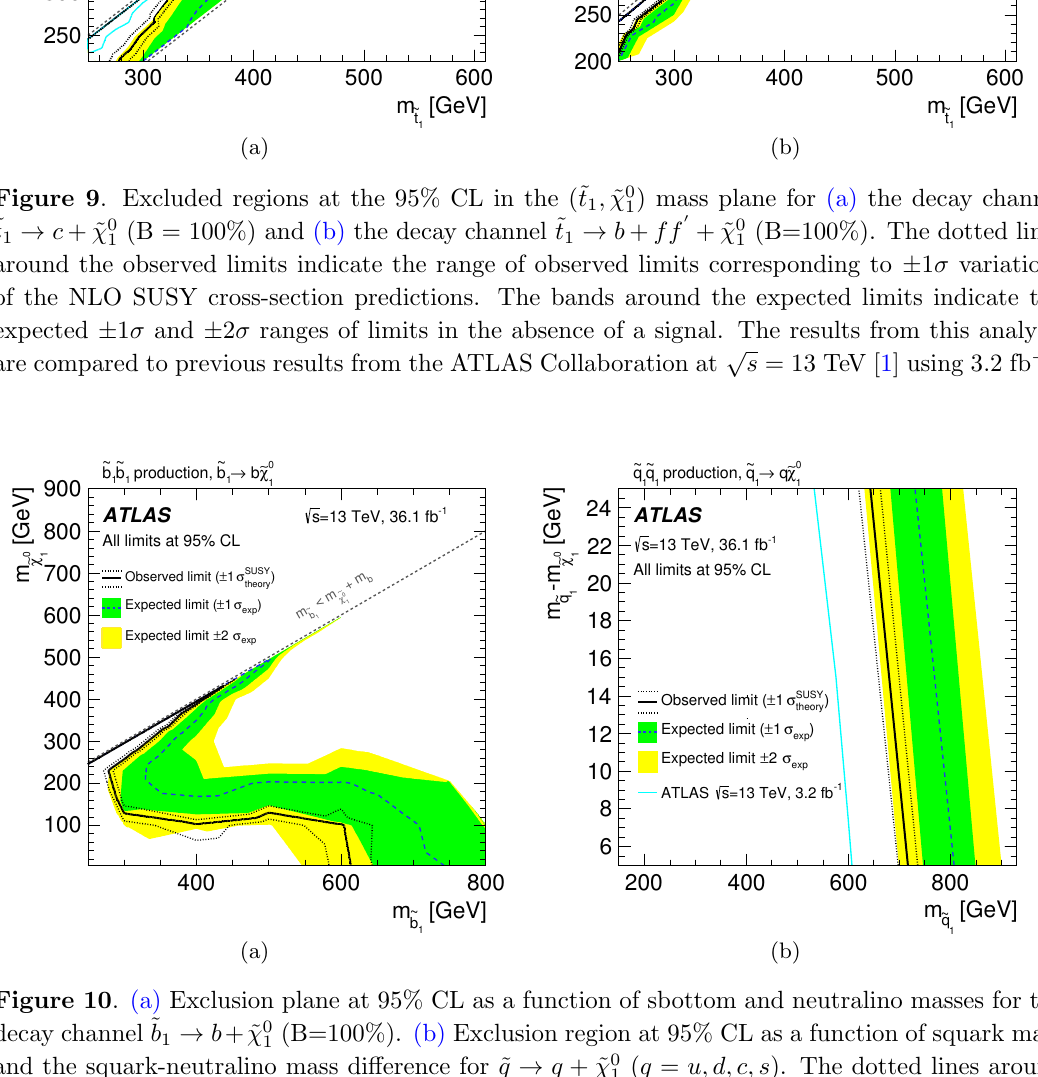
Figure 10 . (a) Exclusion plane at 95% CL as a function of sbottom and neutralino masses for the decay channel ~ b 1 ! b + ~ (cid:31) 0 (B=100%). (b) Exclusion region at 95% CL as a function of squark mass 1 and the squark-neutralino mass di(cid:11)erence for ~ q ! q + ~ (cid:31) 0 ( q = u; d; c; s ). The dotted lines around 1 the observed limit indicate the range of observed limits corresponding to (cid:6) 1 (cid:27) variations of the NLO SUSY cross-section predictions. The bands around the expected limit indicates the expected (cid:6) 1 (cid:27) and (cid:6) 2 (cid:27) ranges of limits in the absence of a signal. The results from this analysis are compared to p previous results from the ATLAS Collaboration at s = 13 TeV [1] using 3 : 2 fb (cid:0) 1